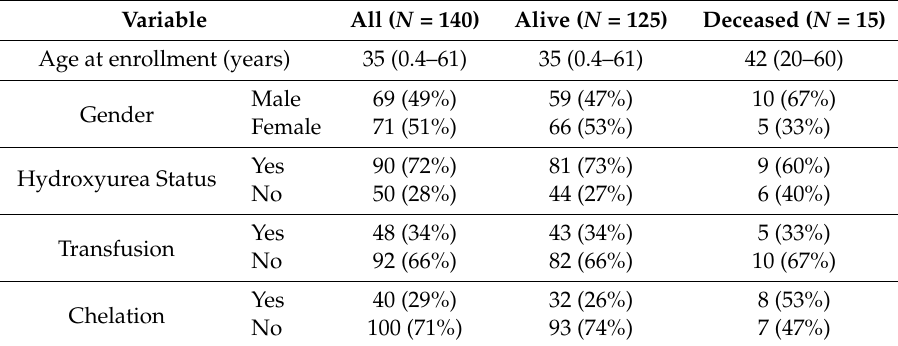
Table 1. Demographics and medical treatments at the last clinic